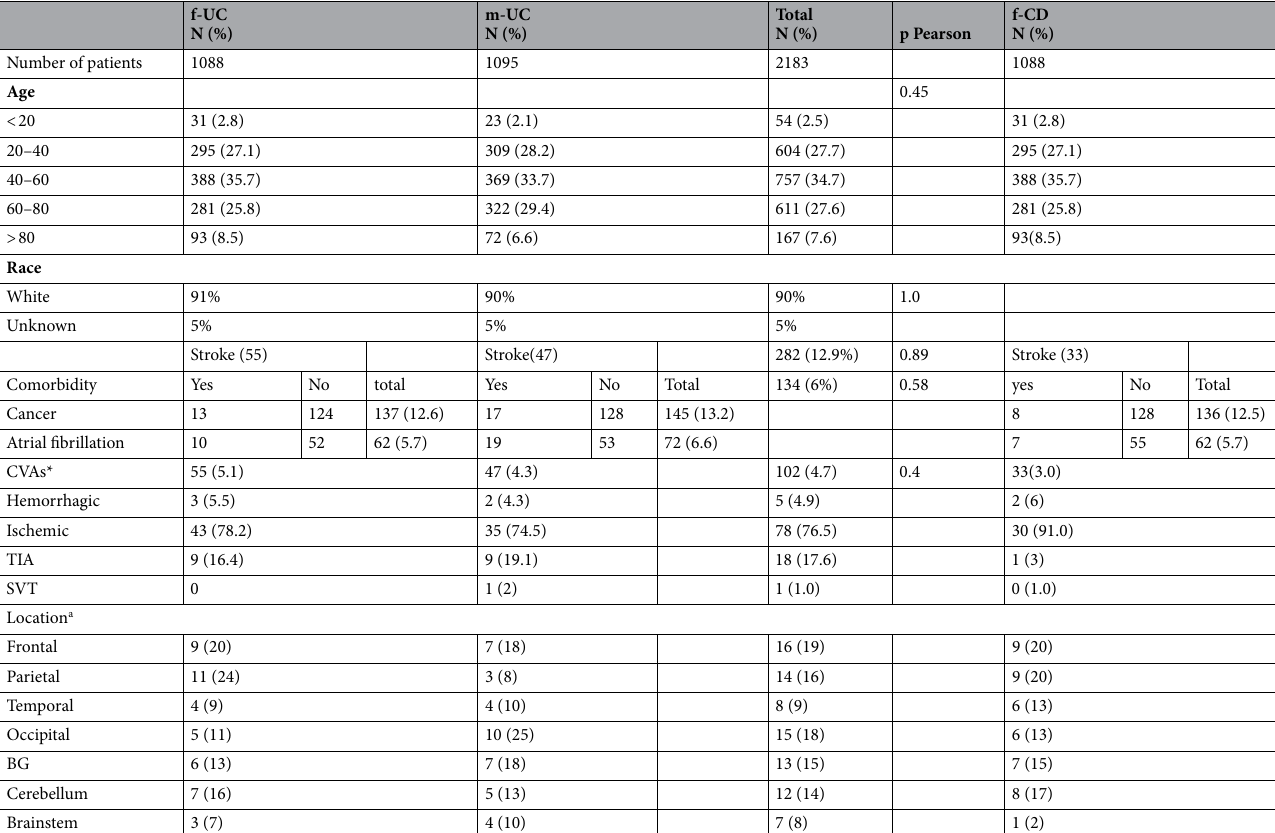
Table 1. Demographics and comorbidities of patients with IBD. a For those patients that location of stroke was available, patients with multiple stroke locations were counted only once for prevalence, but each location was counted separately for stroke location. CVA cerebral vascular accident, TIA transient ischemic attack, SVT sinus venous thrombosis, BG Basal